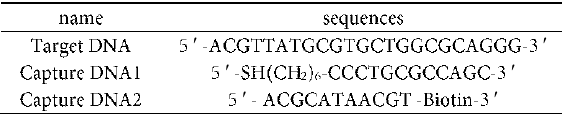
Table 1. sequences of target DNA and capture DNA1 and capture